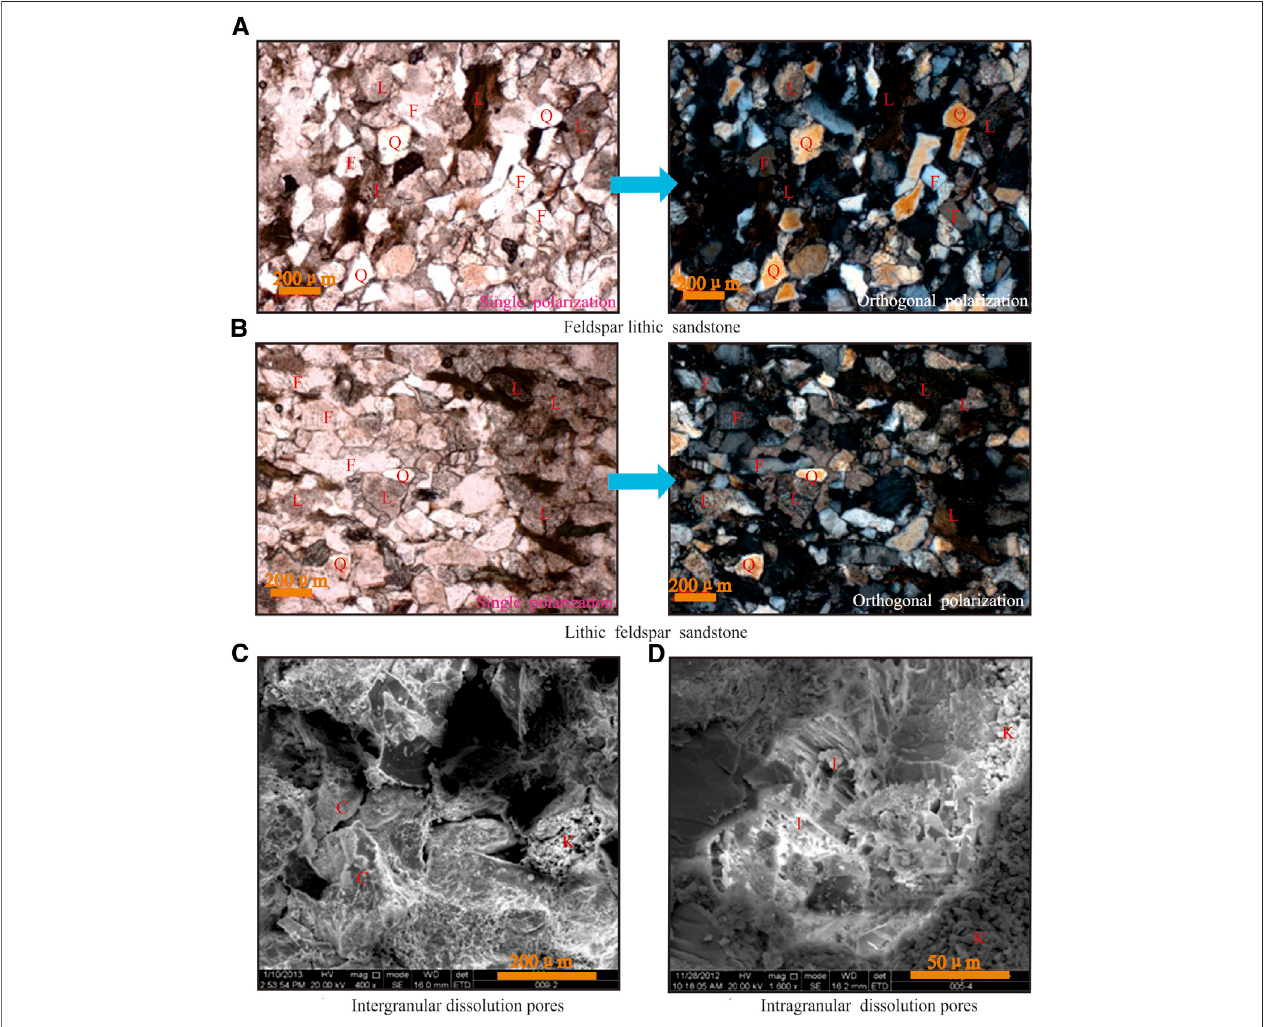
FIGURE 4 | Photomicrographs and scanning electron microscopy (SEM) images of the Chang 3 sandstone. Images on the left of (A) and (B) were test results under plane-polarizedlight,andimagesontherightof (A) and (B) weretestresultsundercross-polarizedlight. (A) WellWB2,544.60 m,×50; (B) WellWB2,547.71 m,×50; (C) Well WB11, 395.84 m, intergranular pores with chlorite fi lm on the surface of the particles. In addition, the pores are fi lled with book-like authigenic kaolinite; (D) Well WB15, 226.17 m; intragranular dissolution pores; and the pores are fi lled with kaolinite and illite. Q: quartz; R: rock debris; F: feldspar; C: chlorite; K: kaolinite; I: illite.